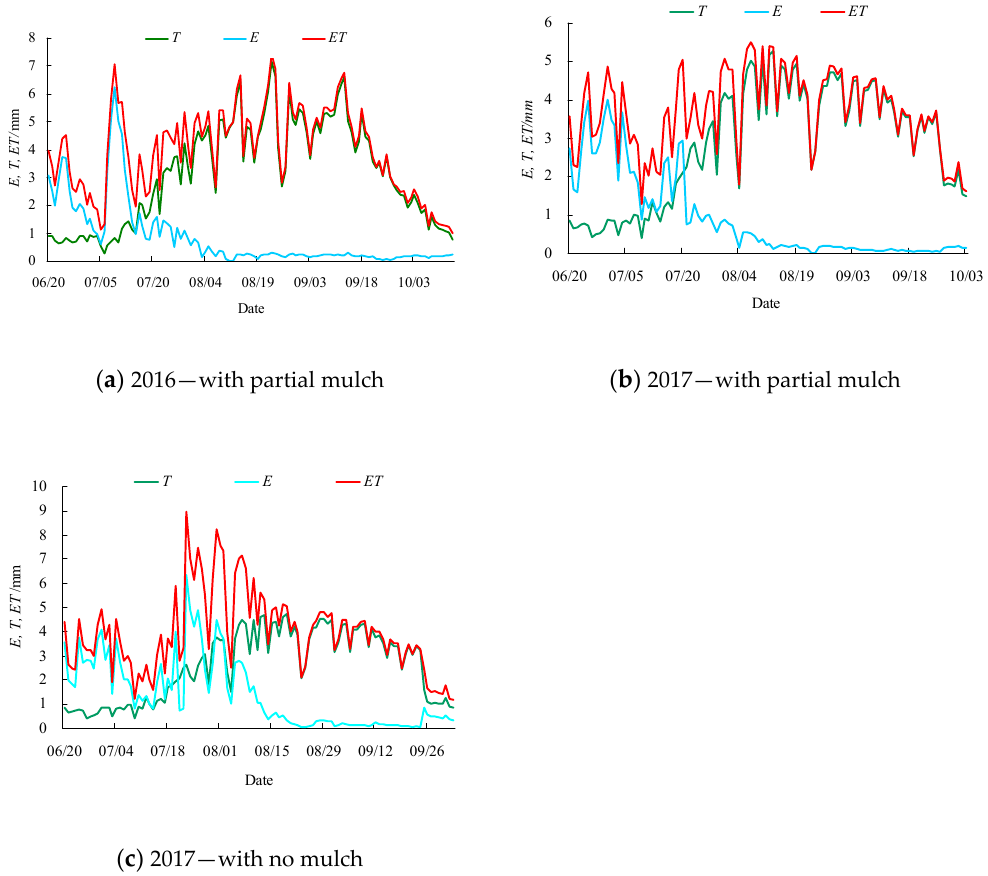
Figure 6. Seasonal variations in evapotranspiration (ET), evaporation (E), and transpiration (T) of summer maize for treatment W1 during the growing season on partially mulched and non-mulched plots in Xinjiang, China. ( a ) 2016—with partial mulch; ( b ) 2017—with partial mulch; ( c ) 2017—with no mulch. Table 8. Variations in T, E, T/ET, and E/ET of summer maize on partial mulched and non-mulched plots during different growth periods in Xinjiang, China.